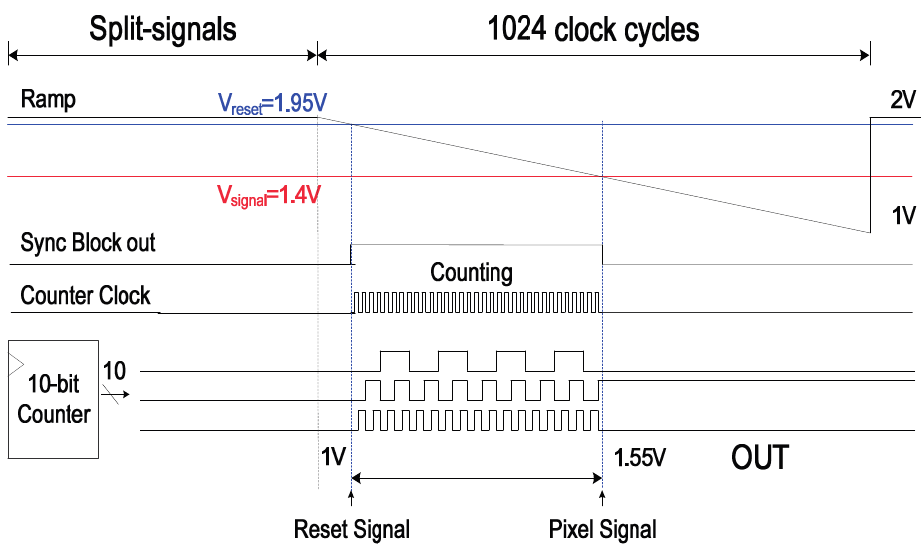
Figure 4. Timing diagram of a SS ADC with the novel digital